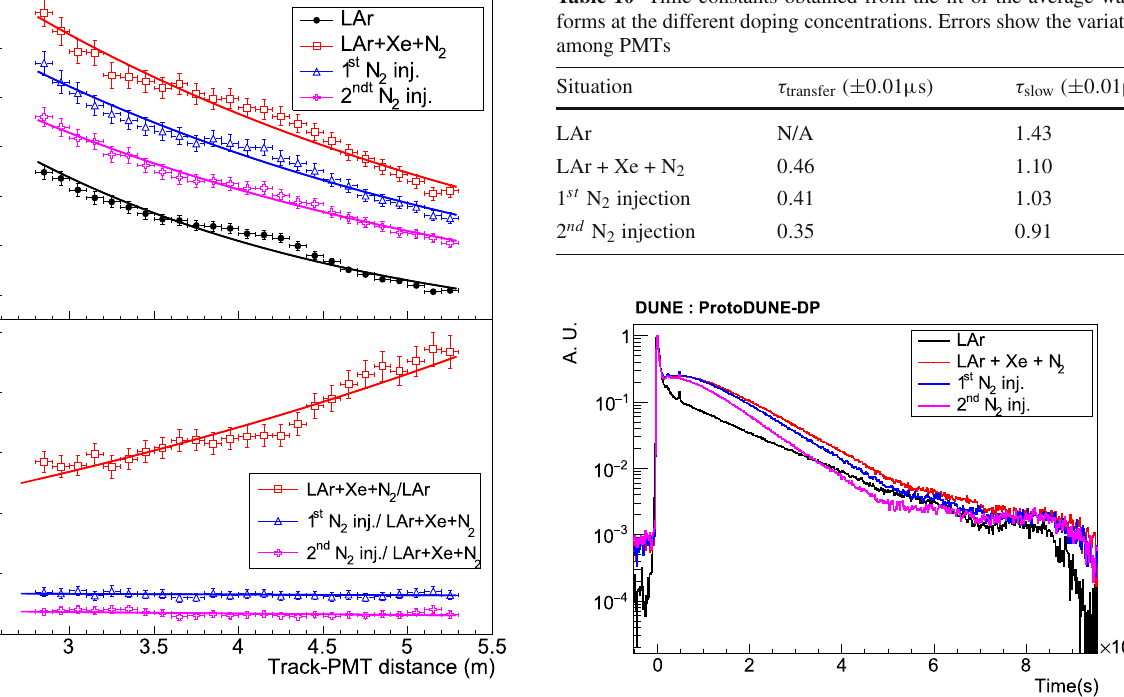
Fig. 29 PMT average waveform normalized to same amplitude in LAr (black), LAr + Xe + N 2 (red), after the 1 st N 2 injection (blue) and after the 2 nd N 2 injection (magenta). Concentrations are described in Table 9 ( τ transfer ) and decay ( τ slow ) of the second bump from the Xe